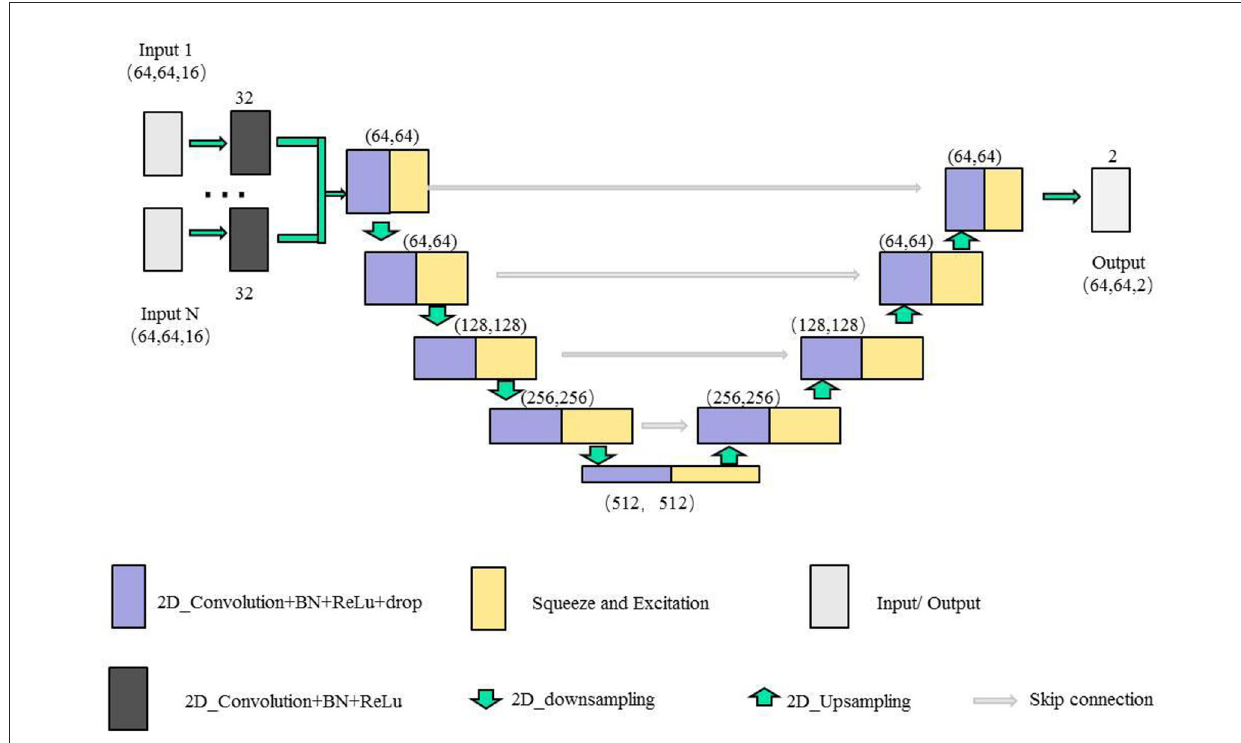
FIGURE6 The illustration of the multiple features SE-Unet